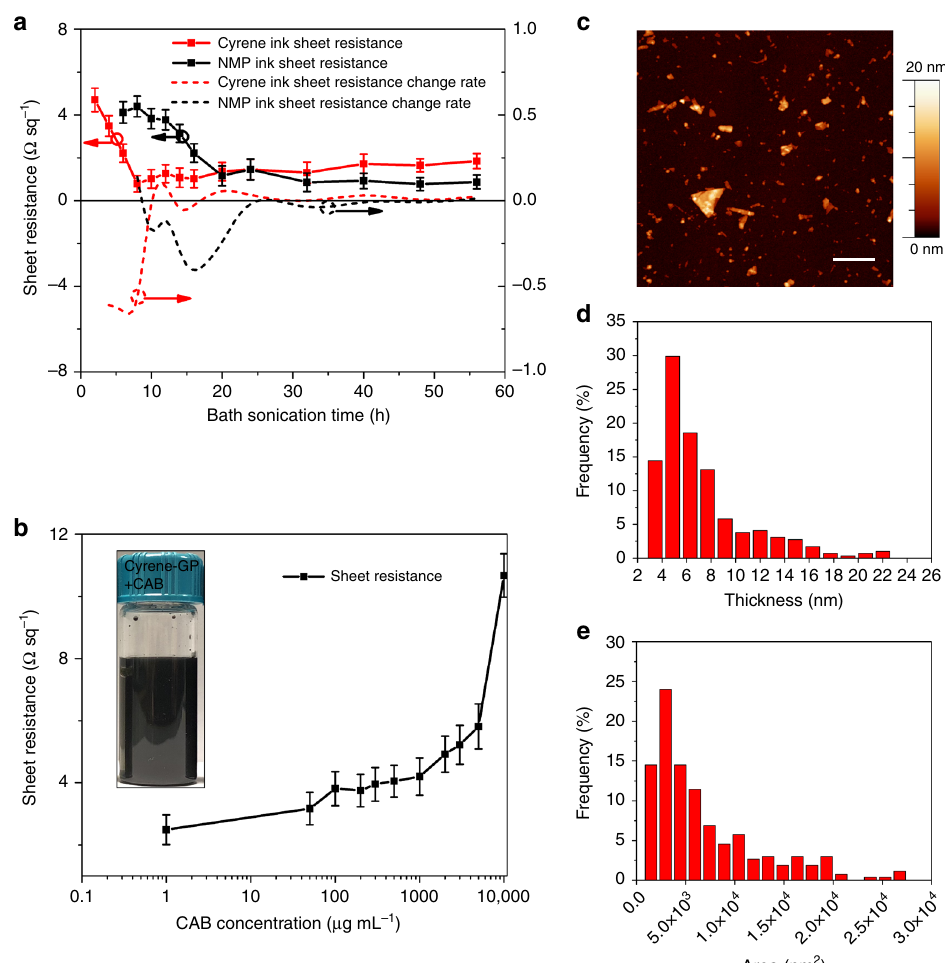
Fig. 1 Quality of exfoliated graphene fl akes in Cyrene. a Measured average sheet resistance values (left axis, measured fi ve times per point) and variation (right axis) of sheet resistance as a function of sonication time (black line: NMP, red line: Cyrene). b Sheet resistance variation (measured fi ve times per point) with different CAB concentrations and the insert sample of 10 mg mL − 1 graphene ink with 1 mg mL − 1 CAB. c AFM image of graphene fl akes on silicon substrate; scale bar is 1 µ m, d thickness histograms and e fl ake